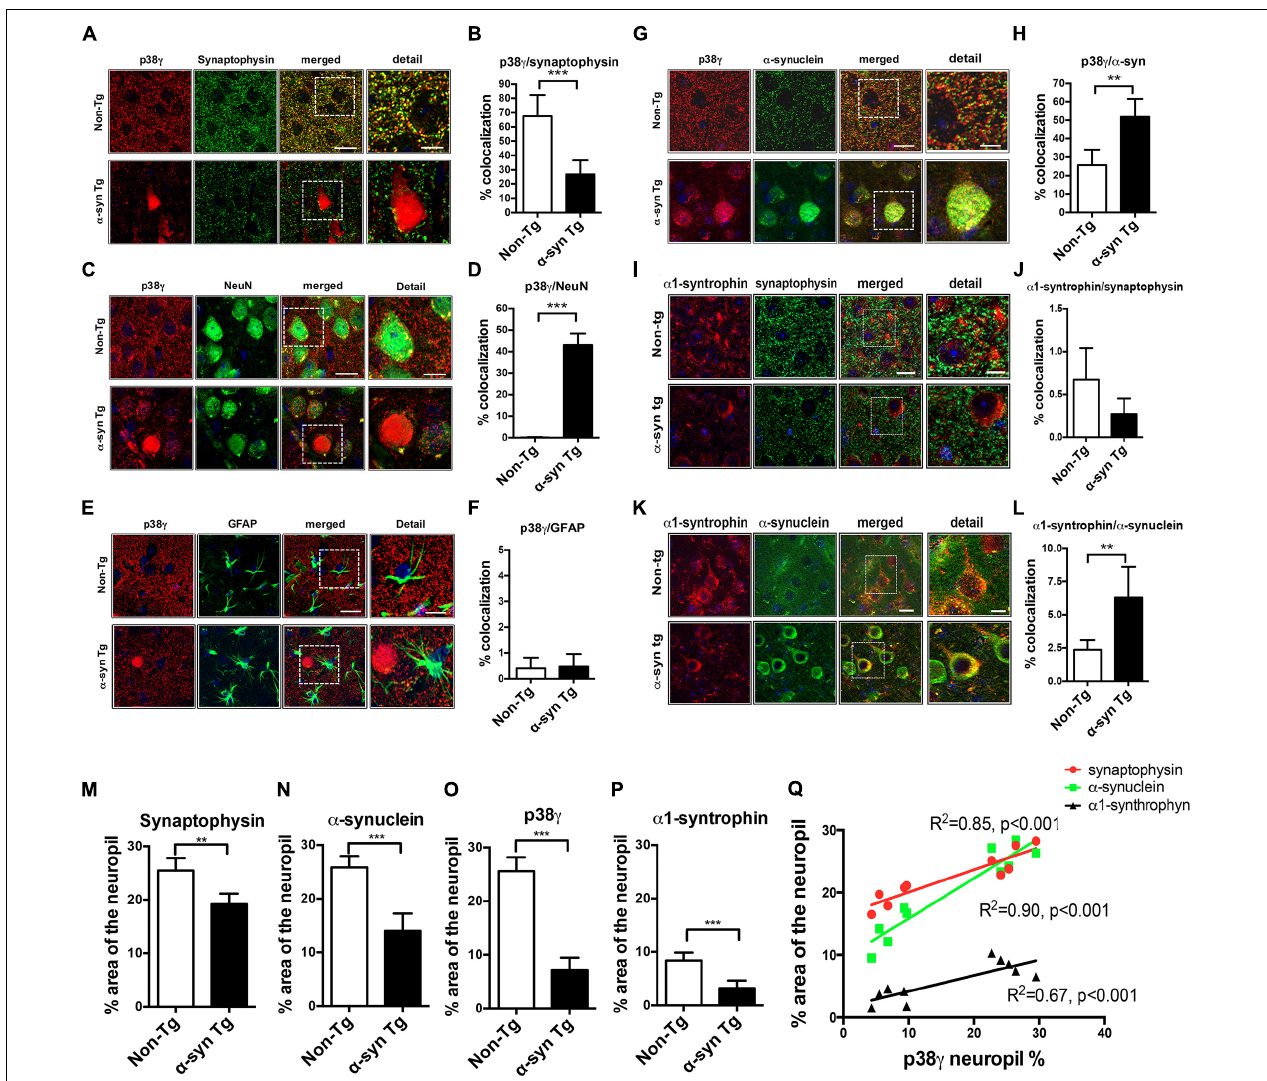
FIGURE 5 | Double immunohistochemical analysis of p38 γ cellular localization in non-Tg and α -syn Tg mouse brains. Vibratome sections of murine brains were double immunofluorescence labeled and analyzed with Apotome II mounted in a Carl Zeiss AxioImager Z1 microscope. Far right (detail): enlarged image of the area contained in the dotted square. (A) p38 γ (red) and the pre-synaptic marker synaptophysin (green), colocalization between the two markers is in yellow; (B) image analysis showing high colocalization of p38 γ to synapses in non-Tg mice; (C) p38 γ (red) and the neuronal marker NeuN (green); (D) image analysis showing increased localization of p38 γ to neurons in α -syn Tg mice; (E) p38 γ (red) and the astroglial cell marker GFAP (green); (F) image analysis showing minimal localization of p38 γ to astroglia in mouse brains; (G) p38 γ (red) and α -syn (green); (H) image analysis showing high colocalization of p38 γ to α -syn aggregates in the cytoplasm (Lewy body-like) in α -syn Tg mice. (I) α 1-syntrophin (red) and pre-synaptic marker synaptophysin (green); (J) image analysis showing low colocalization of α 1-syntrophin to pre-synaptic site in mice brains; (K) α 1-syntrophin (red) and α -synuclein (green); (L) image analysis showing high localization of α 1-syntrophin with α -syn in α -syn Tg mice; Scale bars are 10 µ m in the standard panels and 5 µ m in the zoomed panels. n = 6 per group ( ∗∗ p < 0.01, ∗∗∗ p < 0.001). Image analysis of p38 γ and synaptic proteins in α -syn Tg mouse brains. The single labeled channels from above were further analyzed to calculate the% area of the neuropil occupied by (M) synaptophysin, (N) α -syn, (O) p38 γ , and (P) α 1-syntrophin immunofluorescence in non-Tg and Tg mice. (Q) Linear regression analysis was performed to ascertain the correlation coefficient between the levels of p38 γ in the neuropil (% area) and synaptophysin, α -syn, and α 1-syntrophin in non-Tg and Tg mice. n = 6 per group (** p < 0.01, *** p <